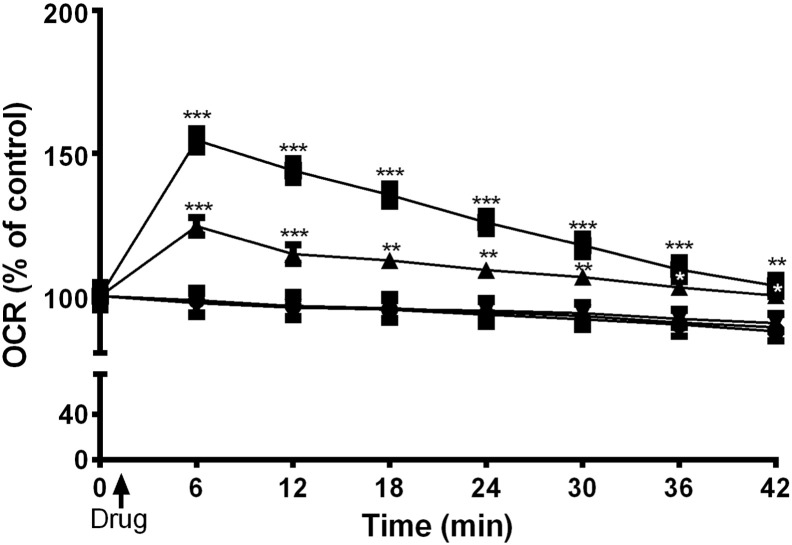
Effect of salicylate, 2,5-DHBA, 2,6-DHBA and 2,4-dinitrophenol on mitochondrial respiration.H4IIE cells were incubated in serum-free medium for 2 h followed by a further 1 h degas. Using a Seahorse analyser (Seahorse Bioscience), oxygen consumption rate (OCR) was measured. After the first reading, 2 mM salicylate (▲), 2 mM 2,5-DHBA (▼), 2 mM 2,6-DHBA (♦), or 100 μM 2,4-dinitrophenol (■) was added. Untreated samples are also shown (●). Data were normalised to untreated samples at zero minutes. Data are from 5 to 10 wells in duplicate. ⁎⁎⁎p < .001, ⁎⁎p < .01, ⁎p < .05 of treated time point with respect to no treatment at the same time point.